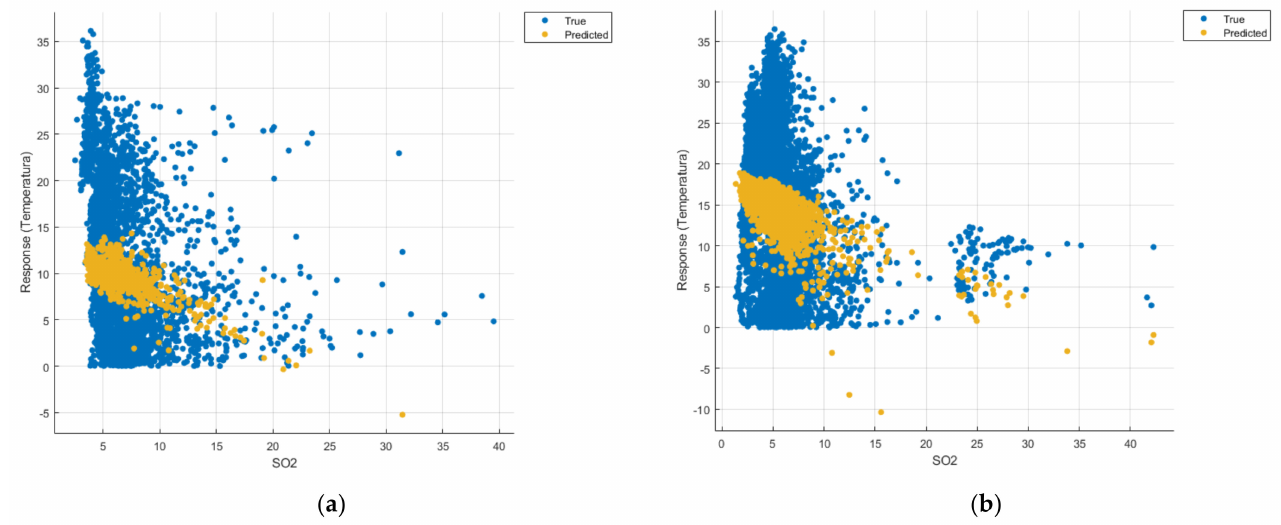
Figure 10. Prediction considering only SO 2 —Linear Regression. ( a ) March 2019–February 2020, ( b ) March 2020– February 2021.